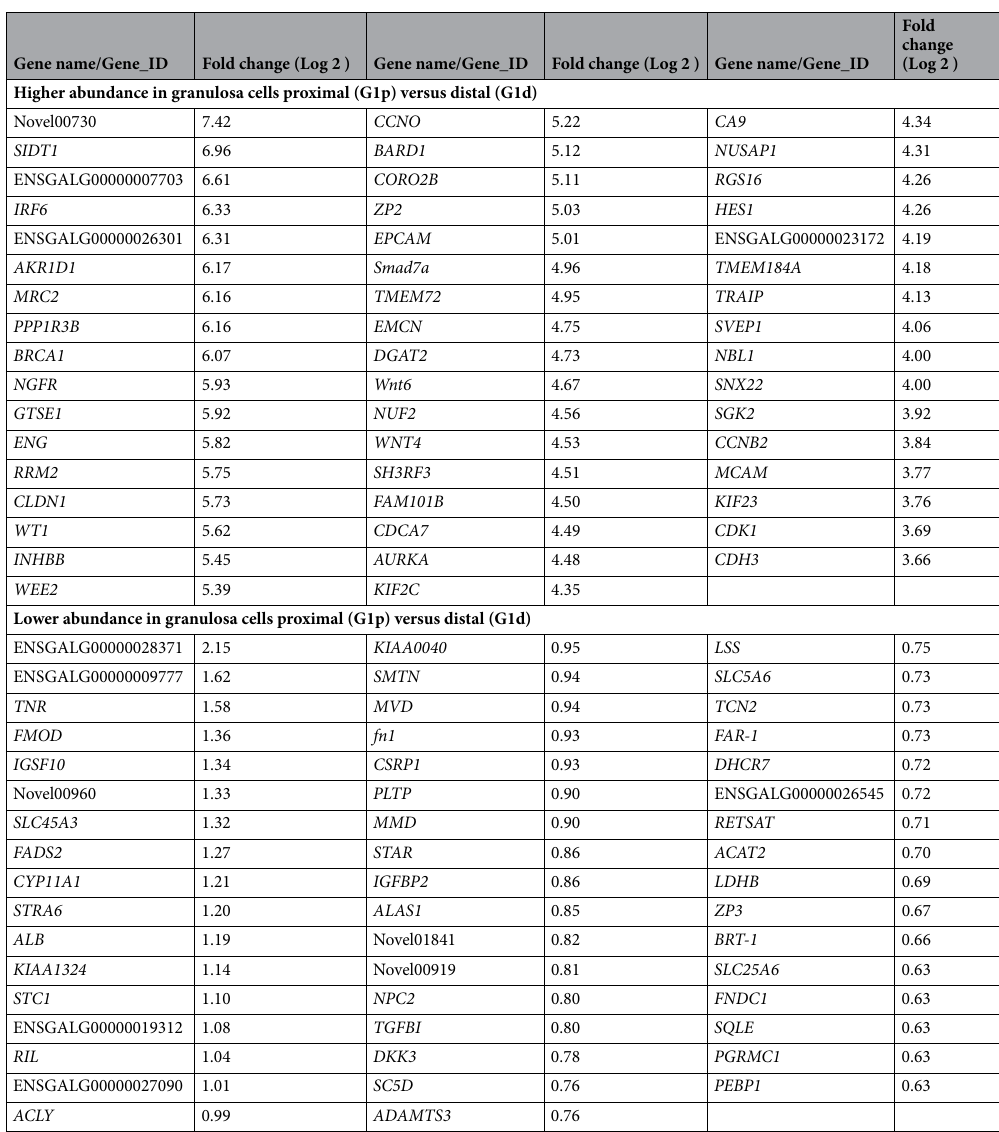
Table 3. Top 50 genes showing significant up or down regulation tendency in granulosa cells proximal and distal to the germinal disc (GD) in F1 follicles (q <